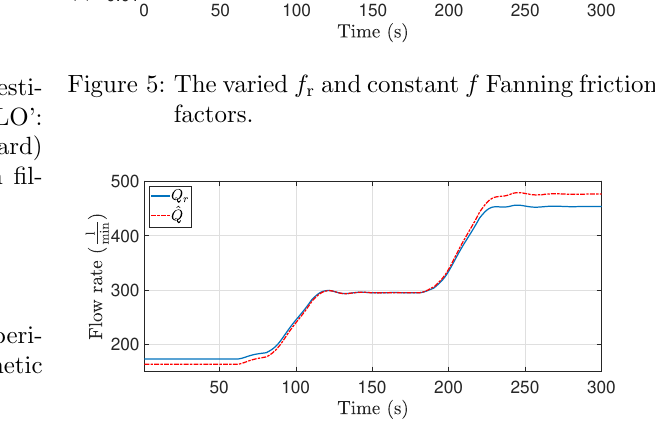
Figure 6: Estimated flow rate ( ˆ Q ) with a constant Fan- ning friction factor f . The reference model results ( Q r ) are plotted for variable f r .